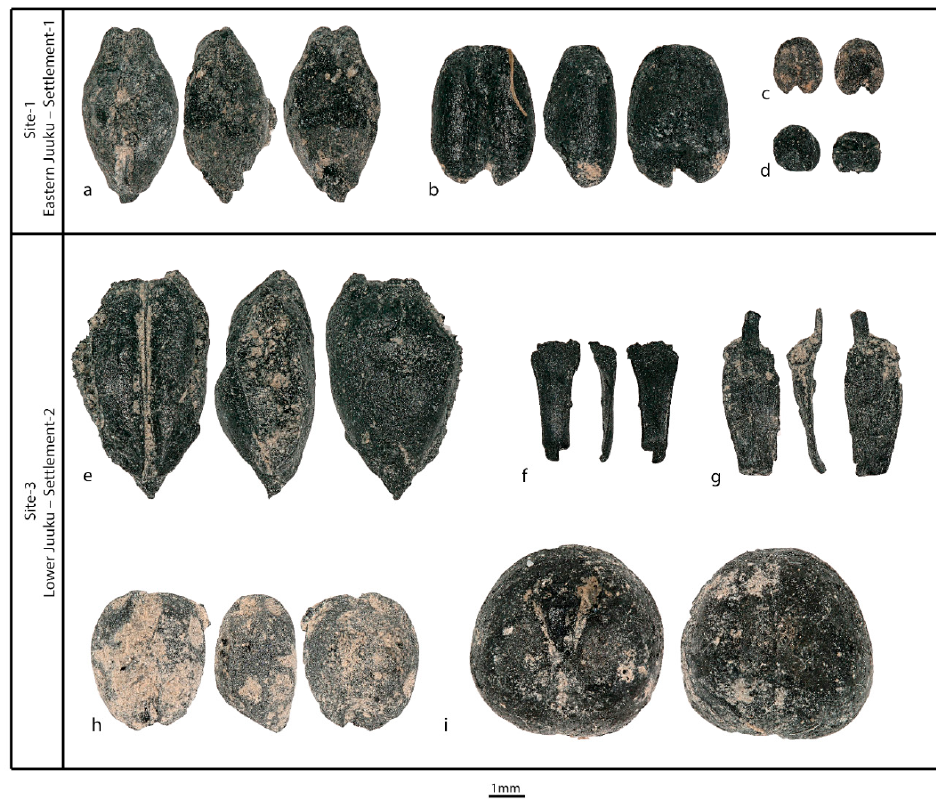
Figure 6. Site-EJS1: ( a )— Hordeum vulgare , ( b )— Triticum aestivum , ( c )— Setaria italica , ( d )— Panicum millaceum ; Site-LJS1: ( e )— Hordeum vulgare , ( f )—Rachis of Hordeum vulgare , ( g )—Rachis of Triticum aestivum , ( h )— Triticum aestivum , and ( i )— Pisum sativum .